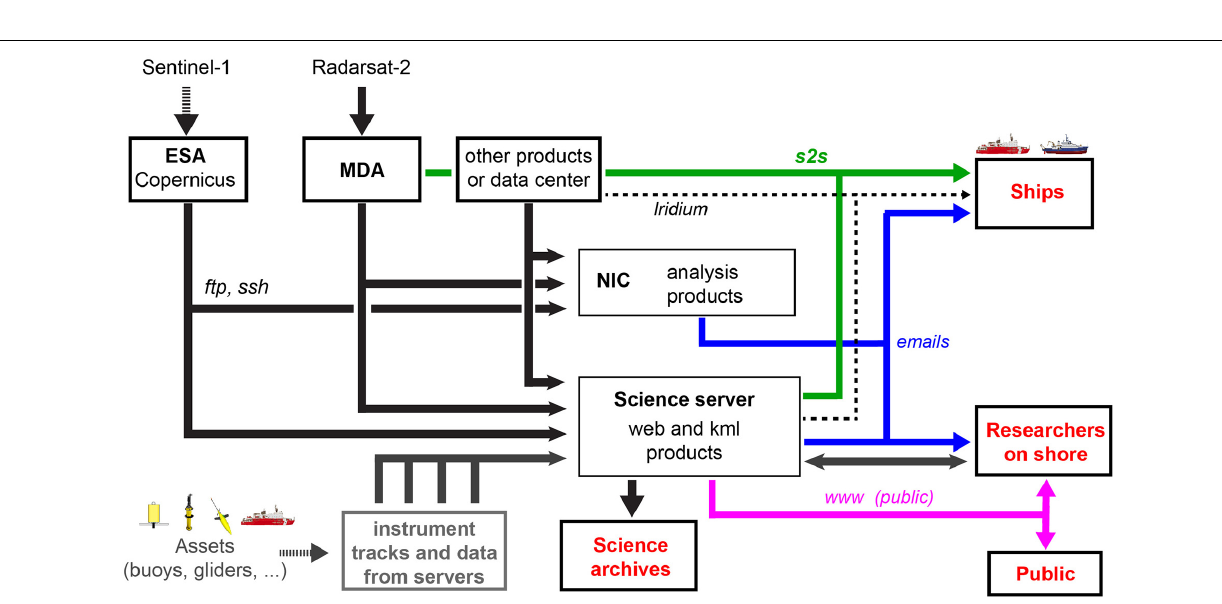
Frontiers in Marine Science |